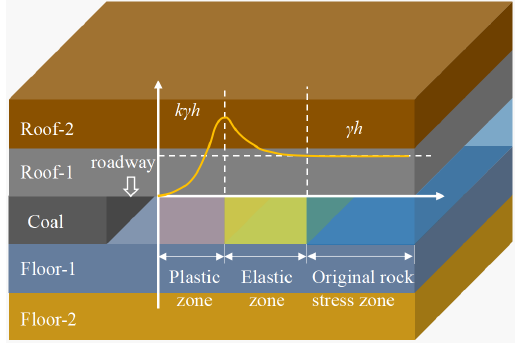
Figure 13. Classification of roadway side coal mass state.